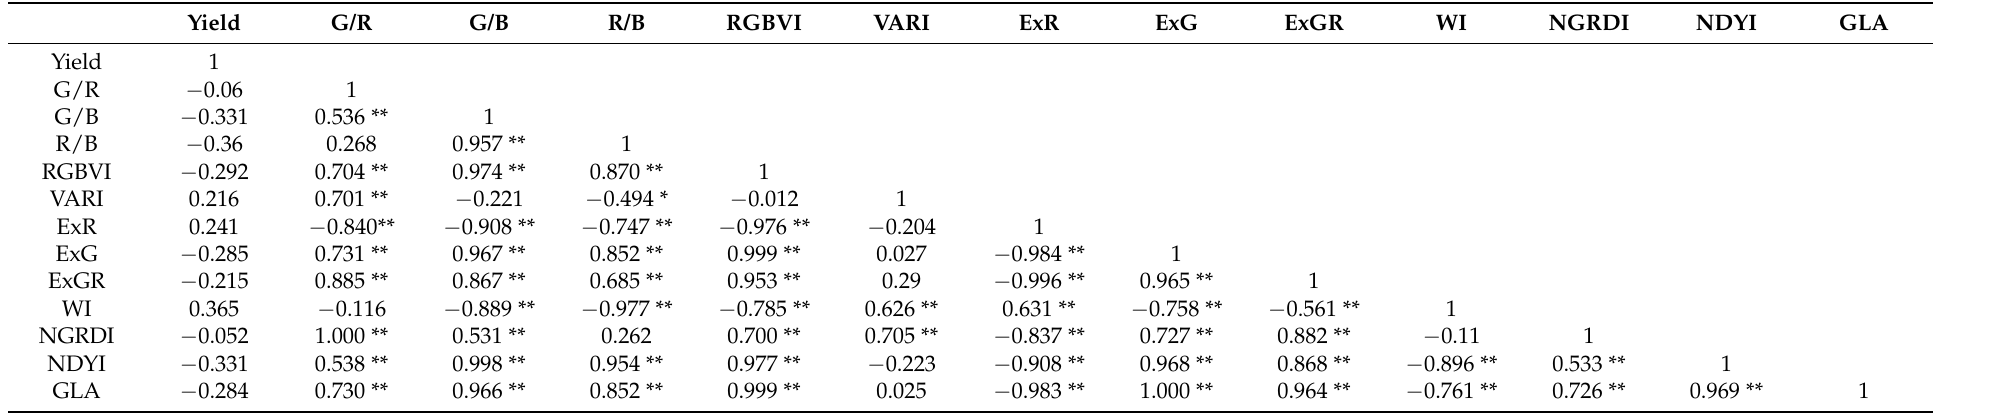
Table 4. Correlation analysis of the UAV-based spectral features and